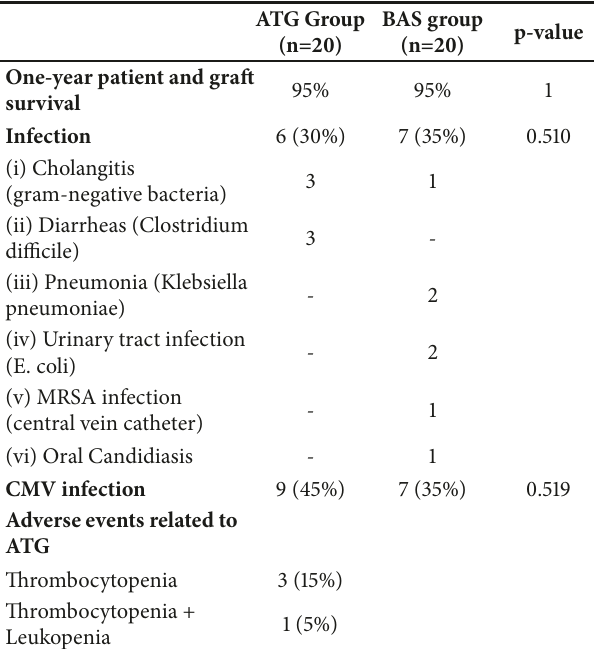
Table 2: Results of secondary